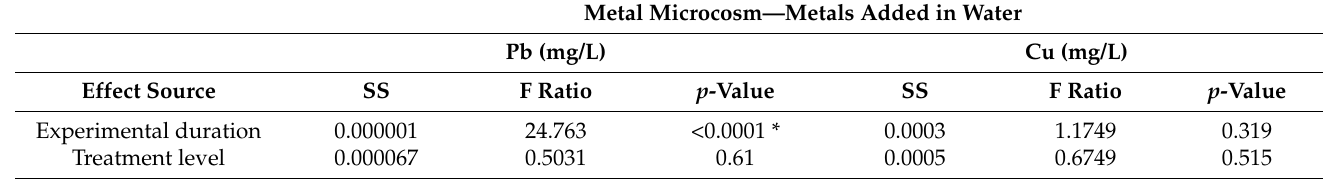
Table A1. Effect test from ANOVA showing the significance of experimental duration and treatment level (high and low) on metal (Pb and Cu) added in mg/L in the water and metal detected in ppm in the sediments of metal microcosm and nutrients (NO 3 − and PO 43 − ) added in mg/L in the water of nutrient microcosm. * in the p -value column indicates a strong probability of significance.